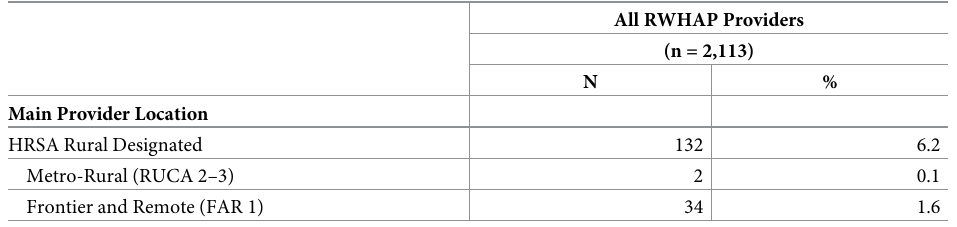
Table 1. Number and percent of HRSA RWHAP providers in rural areas,